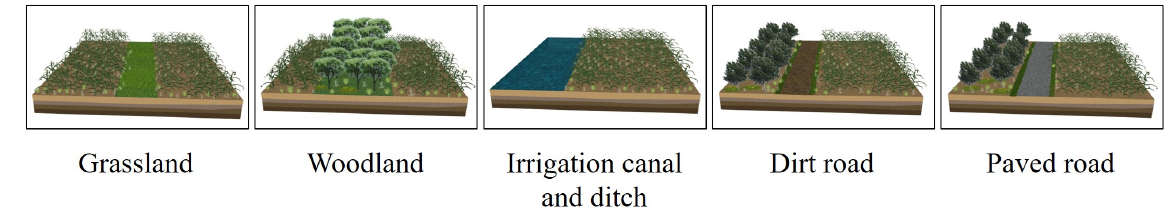
Figure 1. Profile diagram of the 5 types of field margins with typical characteristics in the study area. The overall structure is semi-natural habitat-field margin-corn field. Field margins are divided into grassland, woodland, irrigation canals and ditches, dirt roads, and paved roads.